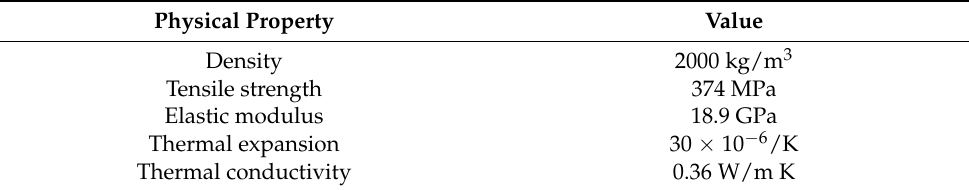
Table 4. Properties of the ISOVAL FR4-HF epoxy at 25 ◦ C.